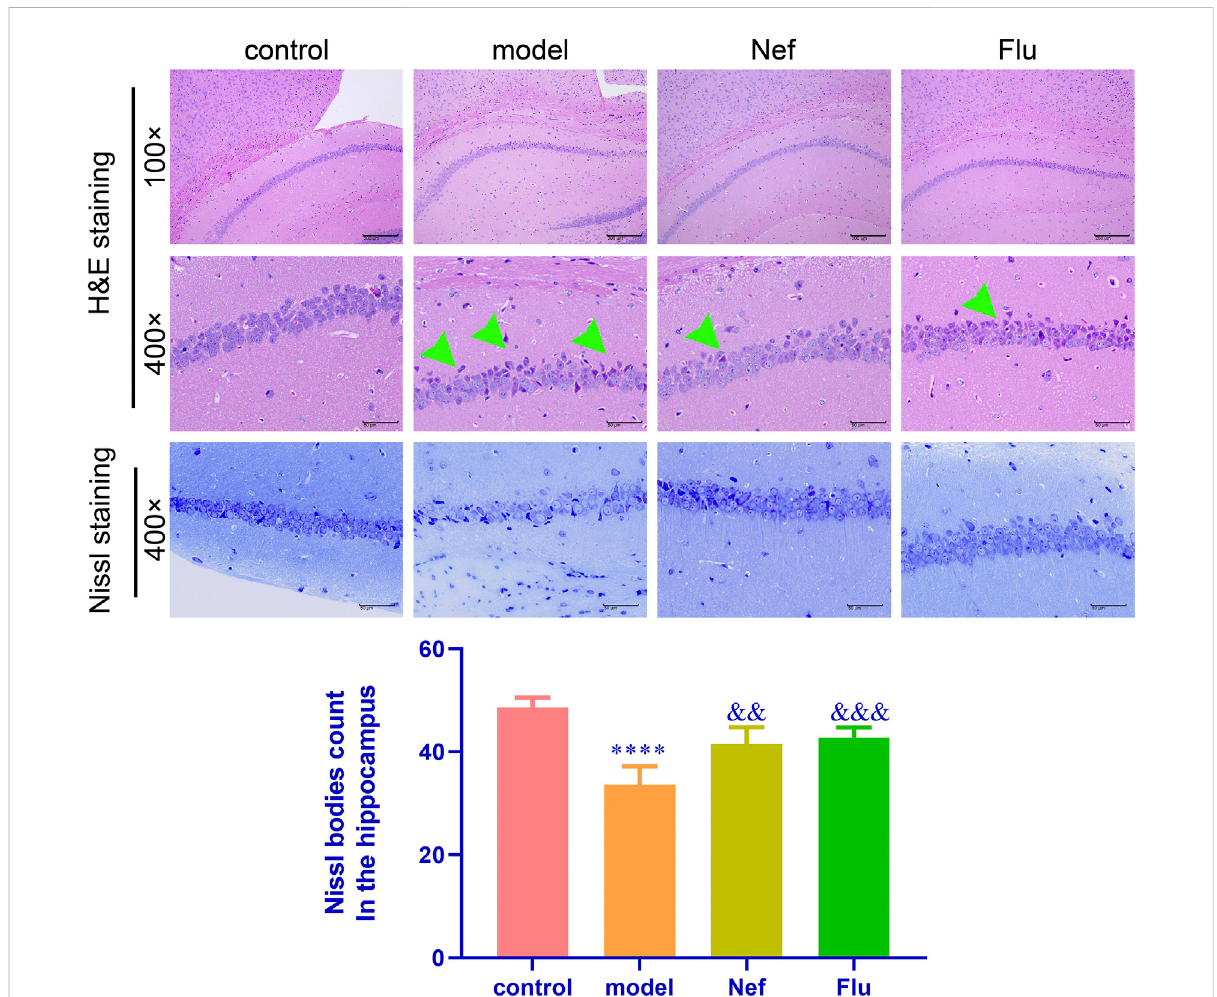
Nefalleviatespathologicaldamageinthehippocampusofdepressedmice.H&E,hematoxylinandeosin;Greenarrow,necroticpyramidalcells; Nef, neferine; Flu, fl uoxetine. Both Nef and Flu both reduced pyramidal cell necrosis and increased Nissl body count in the hippocampus of depressedmice. Dataarepresentedasmean±standarddeviation(SD; n =5pergroup).**** p < 0.0001vscontrol; && p < 0.01, &&& p < 0.001